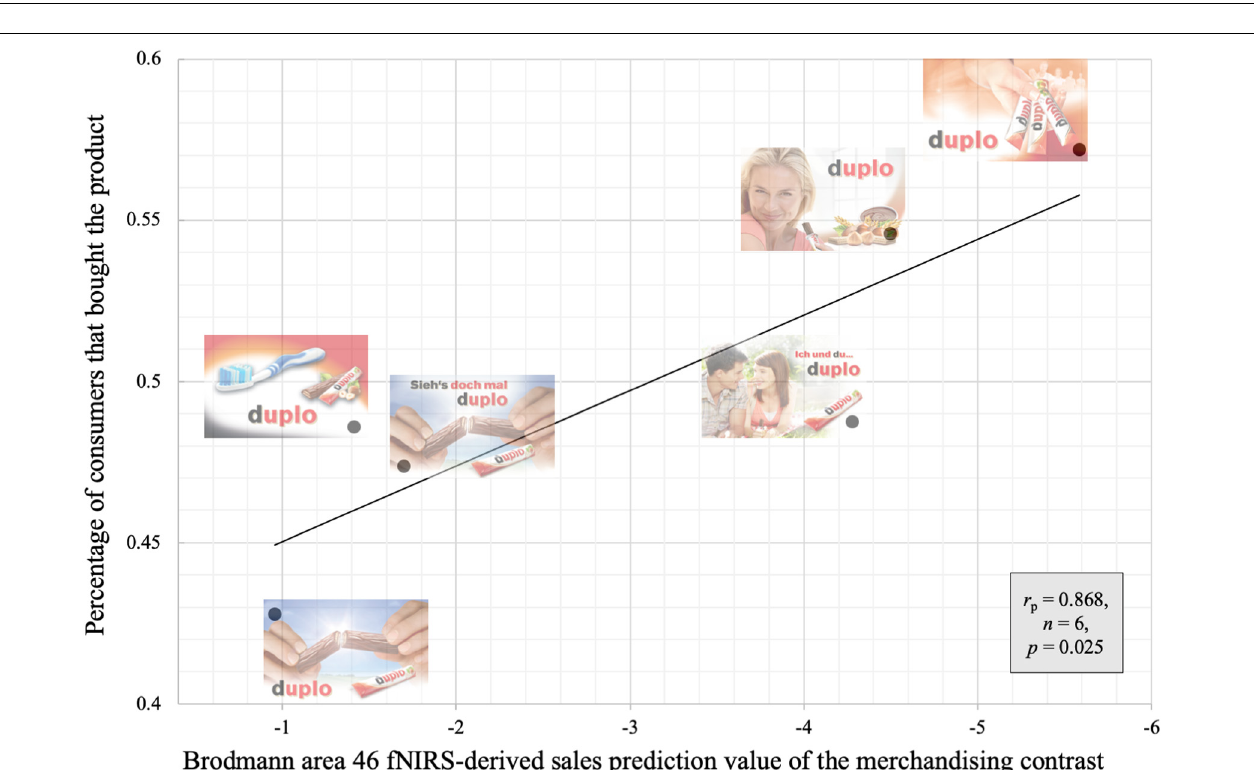
FIGURE 5 | T -value coloured activation maps for the contrast of merchandising element against the implicit baseline. The associated merchandising element is displayed behind the brain map. Channel allocation can be found in Figure 4B . Colour bar indicates the t -values of the contrasts.